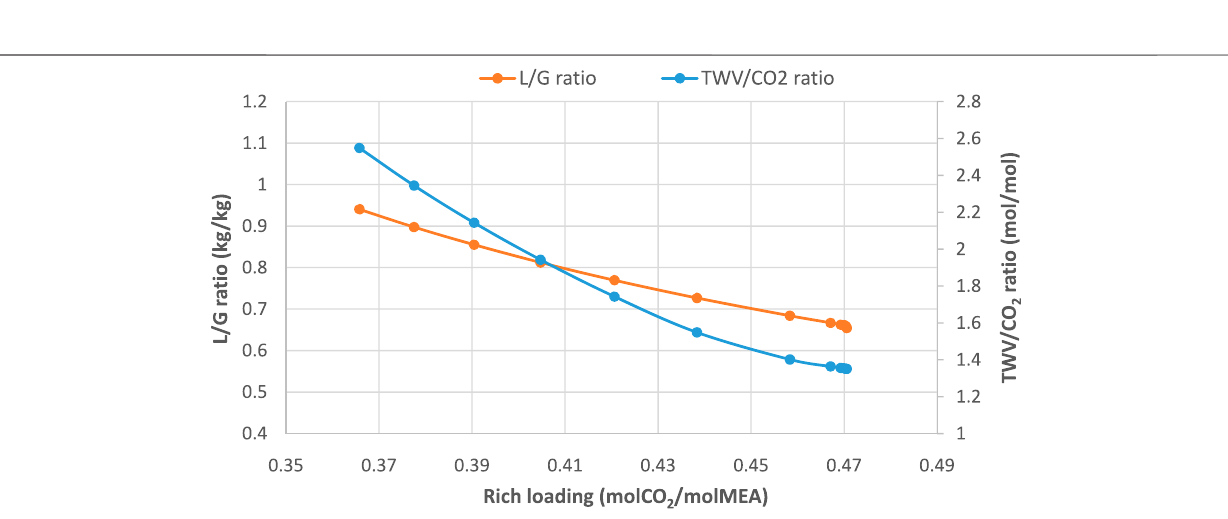
Frontiers in Energy Research |